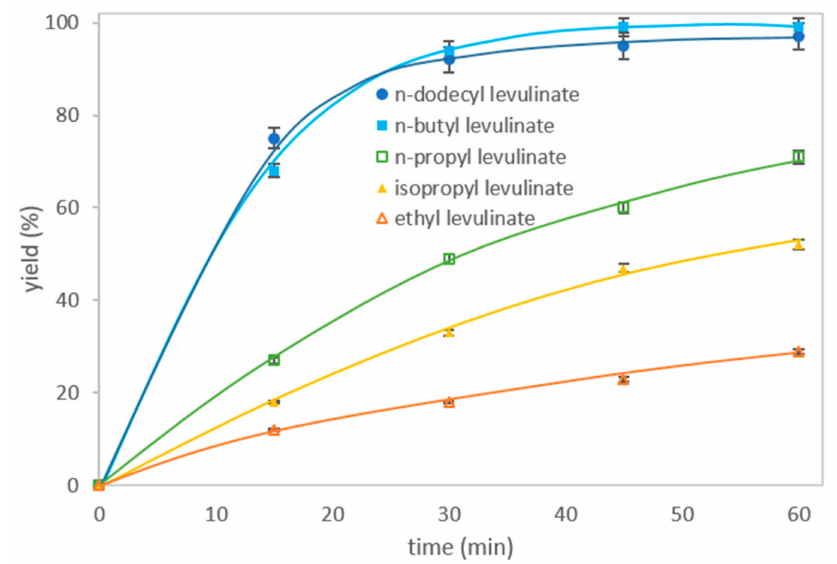
Figure 8. The effect of the alcohol on LA esterification. Reaction conditions: LA (0.117 g, 1 mmol); alcohol (2 mmol); biocatalyst CALB/MWCNT-PTFE (0.10 wt.%) (150 mg); cyclohexane (1 mL); 20 ◦ C; 250